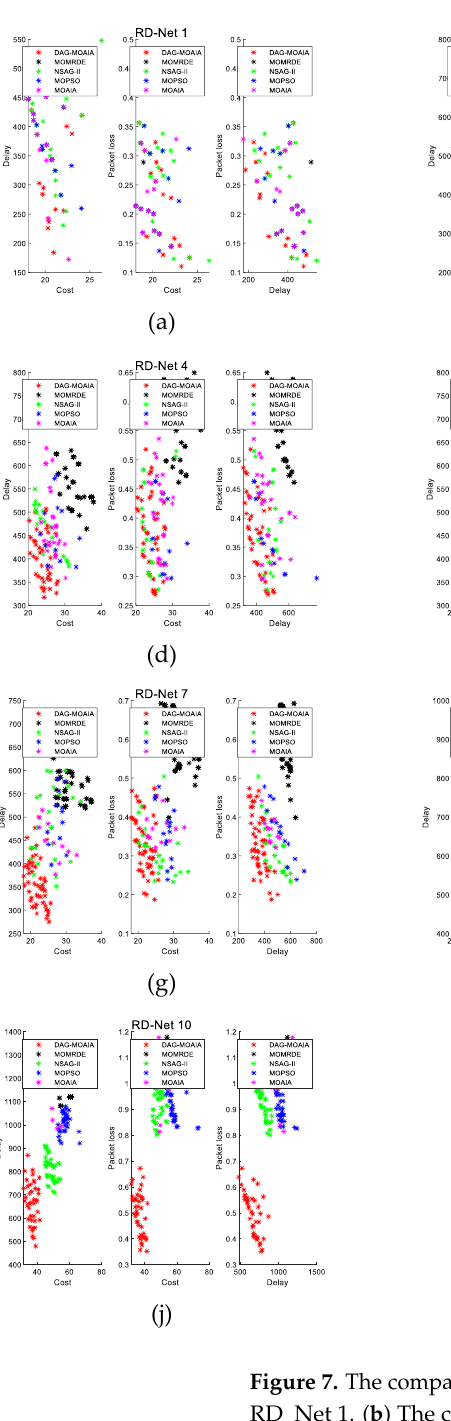
Figure 7. The comparison of bi-objective in the Pareto front. ( a ) The comparison of bi-objective in the RD_Net 1. ( b ) The comparison of bi-objective in the RD_Net 2. ( c ) The comparison of bi-objective in the RD_Net 3. ( d ) The comparison of bi-objective in the RD_Net 4. ( e ) The comparison of bi- objective in the RD_Net 5. ( f ) The comparison of bi-objective in the RD_Net 6. ( g ) The comparison of bi-objective in the RD_Net 7. ( h ) The comparison of bi-objective in the RD_Net 8. ( i ) The comparison of bi-objective in the RD_Net 9. ( j ) The comparison of bi-objective in the RD_Net